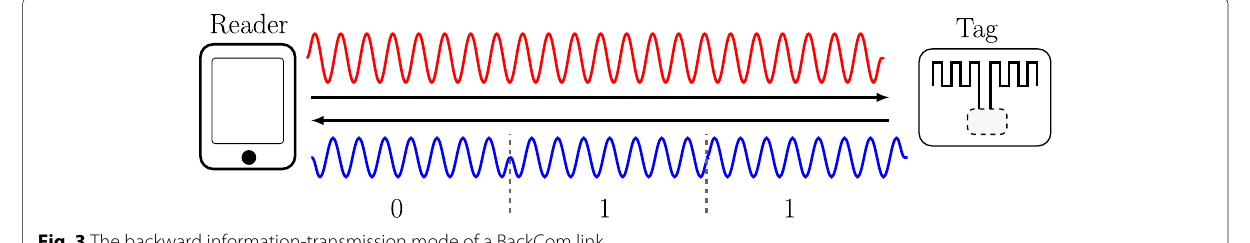
solution is to avoid collisions between multi-tag trans- missions using the traditional MAC schemes includ- ing space/frequency/code/time-division multiple-access (SDMA/FDMA/CDMA/TDMA), see [6] and [12] and ref- erences